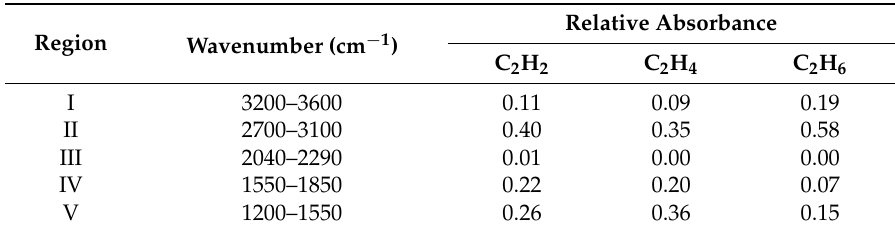
Table 2. Relative absorbance of regions I, II, III, IV, and V (with respect to the integral absorbance of the measured spectral ranges).